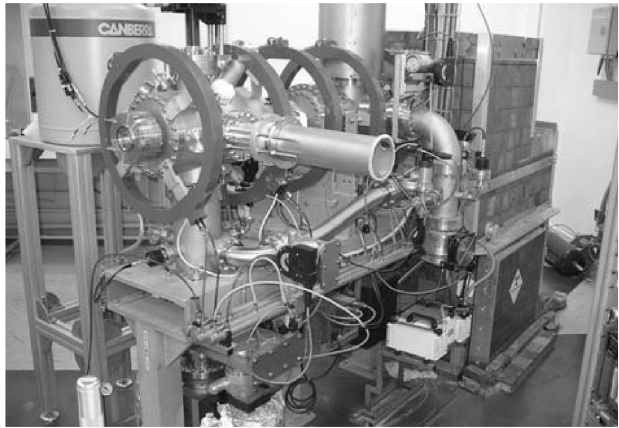
FIG. 4. Picture of the slow positron beam facility in Orle´ans.